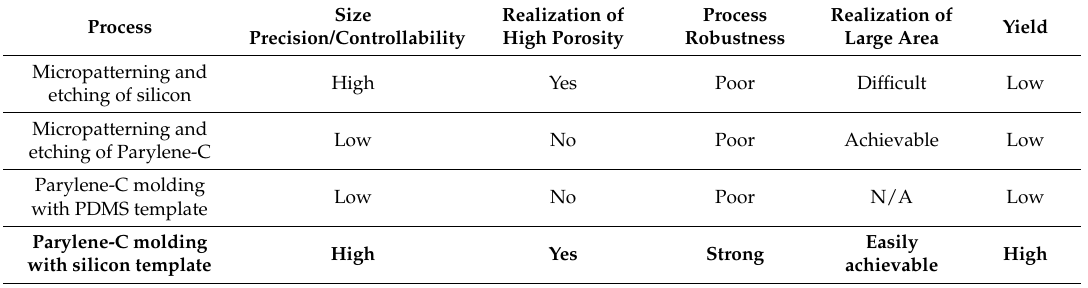
Table 2. Comparison of the four microfabrication processes investigated for micropore